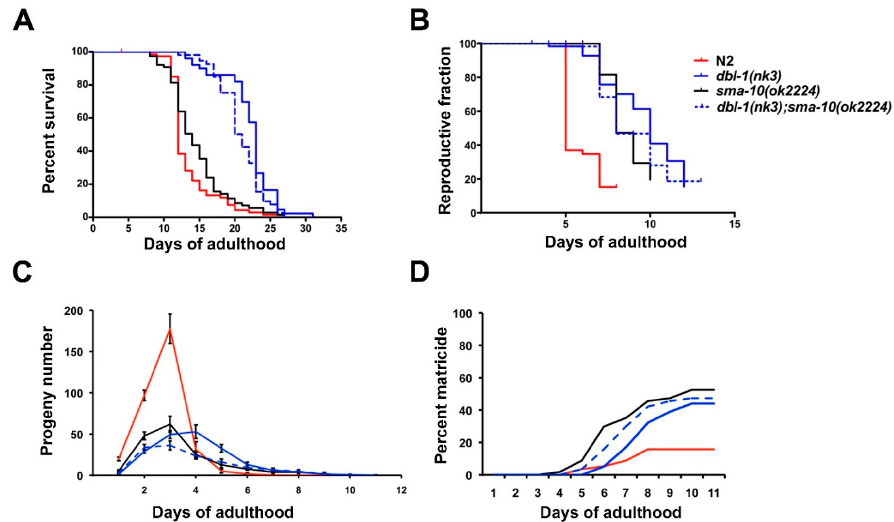
Figure 3. Role of SMA-10 in longevity, fecundity and matricide. Data shown are from one representative experiment. ( A ) Kaplan–Meier plot shows the fraction of animals that survived overtime. Strains were grown at 20 °C in Nematode Growth Medium ( NGM) plates with OP50 and 50 mM FUdR. sma-10(ok2224) worms, in contrast to dbl-1(nk3) and dbl-1(nk3);sma-10(ok2224) , do not show a significant difference with respect to N2. ( B ) Kaplan–Meier plot with the fraction of animals reproductively active overtime. Reproduction span is similar in dbl-1(nk3) , sma-10(ok2224) and dbl-1(nk3);sma-10(ok2224) and significantly longer than in N2. ( C ) Deposition of eggs peaks around day three of adulthood in N2, rapidly decreasing thereafter; in contrast, self-fertilized mutants of sma-10 and dbl-1 not only have a longer depo- sition span but show a lower overall fertility. ( D ) Cumulative percentage of animals with matricide (caused by internal progeny hatching). Matricide rate increases similarly with age in defective mutants of dbl-1 , sma-10 and their double mutant, unlike the slower rate of the wild-type N2.